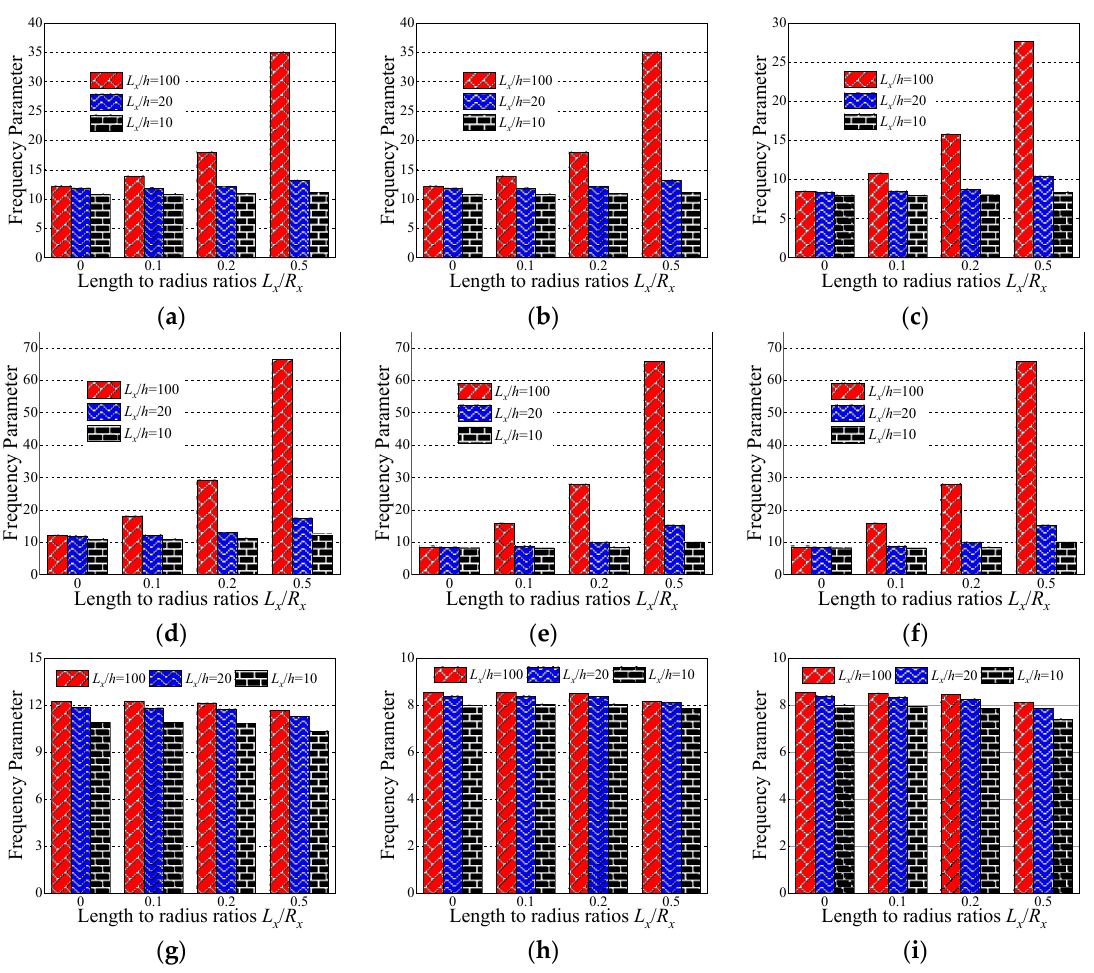
Figure 4. Variation laws of the fundamental frequency parameter Ω for composite laminated shallow shells with the SD-SD boundary condition with respect to various length to radius ratios L x / R x and length to thickness ratios L x / h by first-order shear deformation shell theory (FSDT). ( a ) Cylindrical shell, 0 ° /90 ° /90 ° /0 ° ; ( b ) cylindrical shell, 0 ° /90 ° ; ( c ) cylindrical shell, 90 ° /0 ° ; ( d ) spherical shell, 0 ° /90 ° /90 ° /0 ° ; ( e ) spherical shell, 0 ° /90 ° ; ( f ) spherical shell, 90 ° /0 ° ; ( g ) hyperbolic paraboloidal, 0°/90°/90°/0°; ( h ) hyperbolic paraboloidal, 0°/90°; ( i ) hyperbolic paraboloidal, 90°/0°.